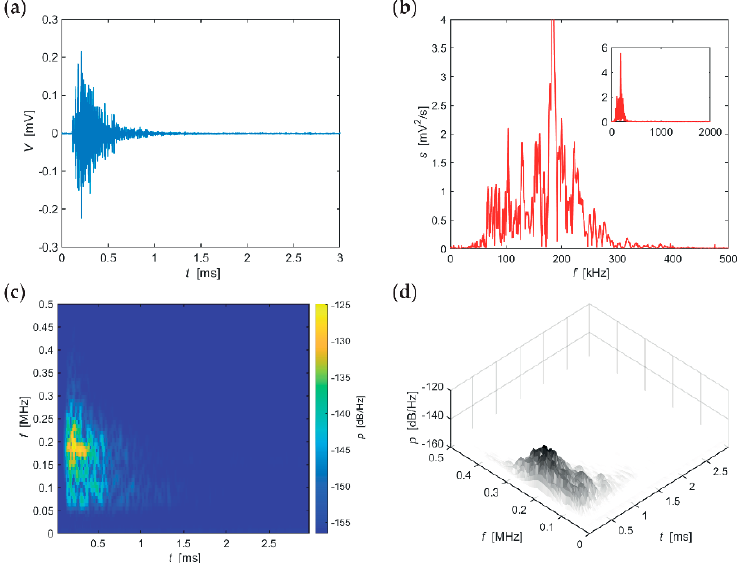
Figure 8. Visualisation of the recorded AE signal during 0–25 F-T cycles from specimens CS150: ( a ) time course of the amplitude, ( b ) frequency spectrum, ( c ) spectrogram STFT-2D image, ( d ) spec- trogram STFT-3D image.